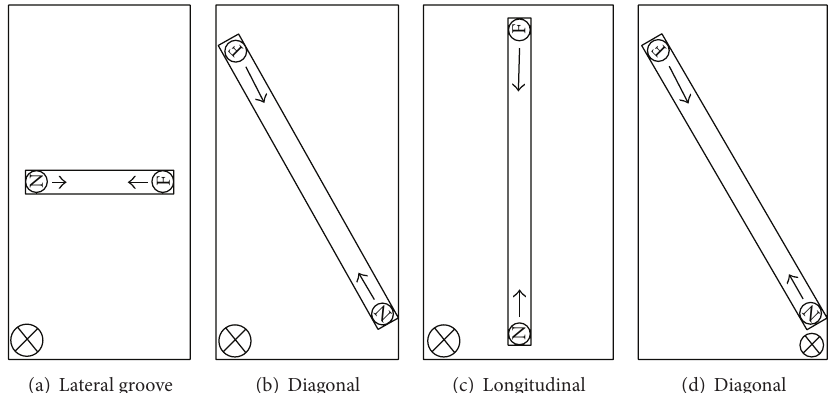
Figure 10: Types of groove in the main body and location of force application in experiments.